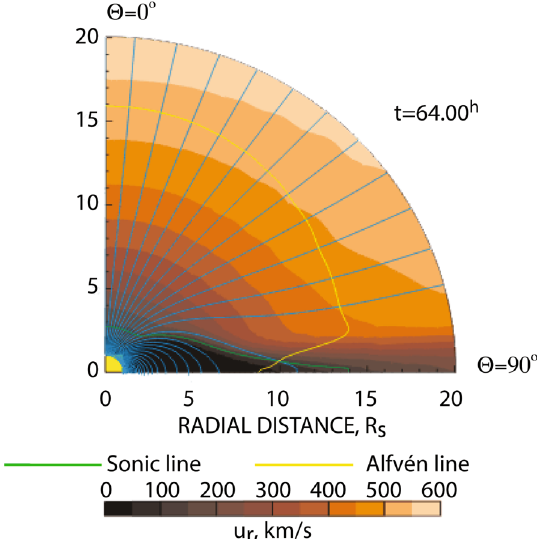
Fig. 20 Magnetic field configuration near the Sun superimposed on a map of radial flow velocities after 64h of relaxation. The Alfvén line (where the radial flow velocity is equal to the Alfvén velocity computed for the total magnetic field) is shown by the yellow line, and the sonic line (where the radial velocity is equal to the sound velocity) is shown by the green line. Image reproduced with permission from Usmanov et al. (2000), copyright by